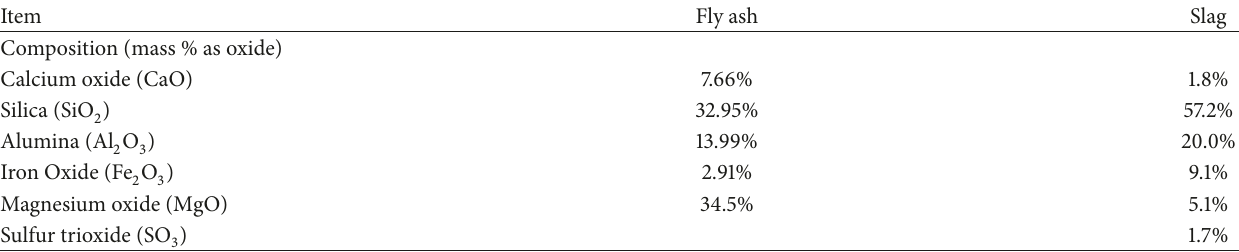
Table 1: Oxide composition of the fly ash and slag.